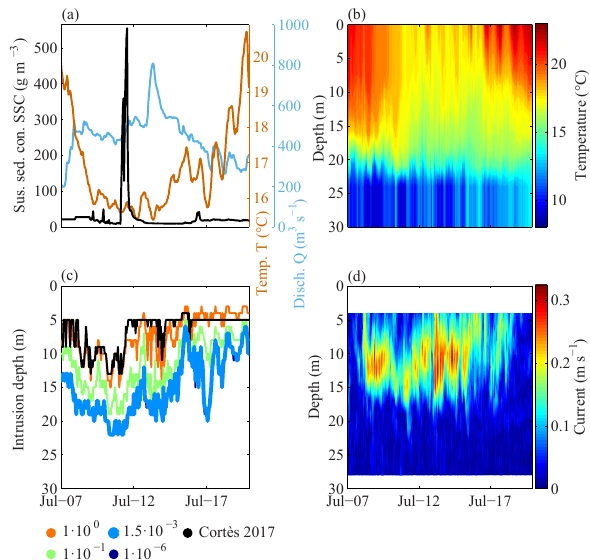
Figure A5. River intrusion entrainment sensitivity analysis for the LB/Aare system in July 2014. (a) SSC (black), temperature ( T ; or- ange) and river discharge ( Q ; blue) from Aare station no. 2085. (b) Lake temperature at M3 station. (c) River intrusion depth calcu- lated as in Appendix A using river/lake density obtained from (a) and (b) with varying entrainment constant β (colored, Eq. 18); light blue denotes the value used in this study; intrusion depth (black) cal- culated with method described in Cortés et al. (2014). (d) Current speed obtained from ADCP at M3 station; velocities > 0.15ms − 1 are associated with the passing river plume.